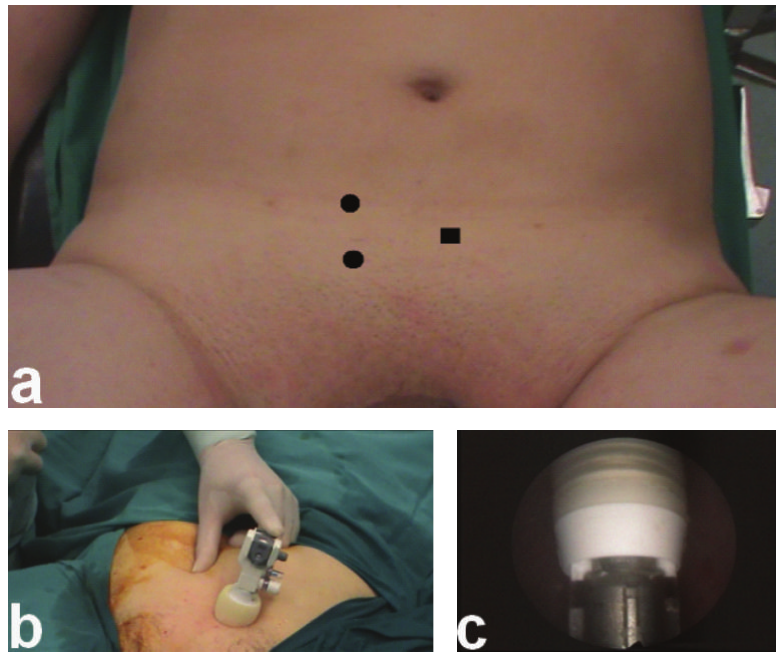
Figure 1: (a) Trocar arrangement for the excision of the left distal ureter. The mirror image of this configuration was used for the other side. ( (cid:2) ) 10 mm camera port; ( • ) 5mm working ports. (b) 10 mm camera port in place. (c) Cystoscopic view of the 10-mm port.